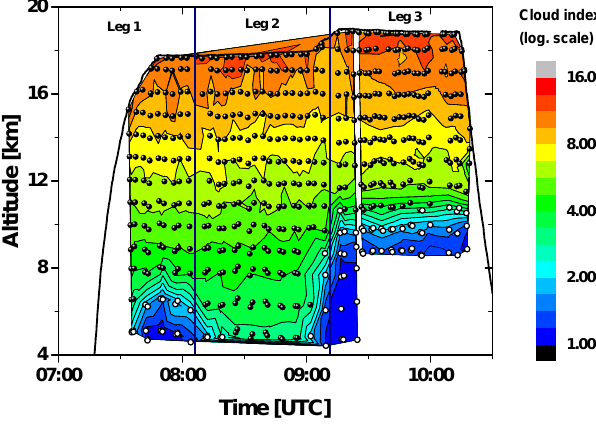
Figure 3. Geolocations of MIPAS-STR limb sounding measure- ments. Figure 4. Vertical flight profile of the Geophysica together with tan-